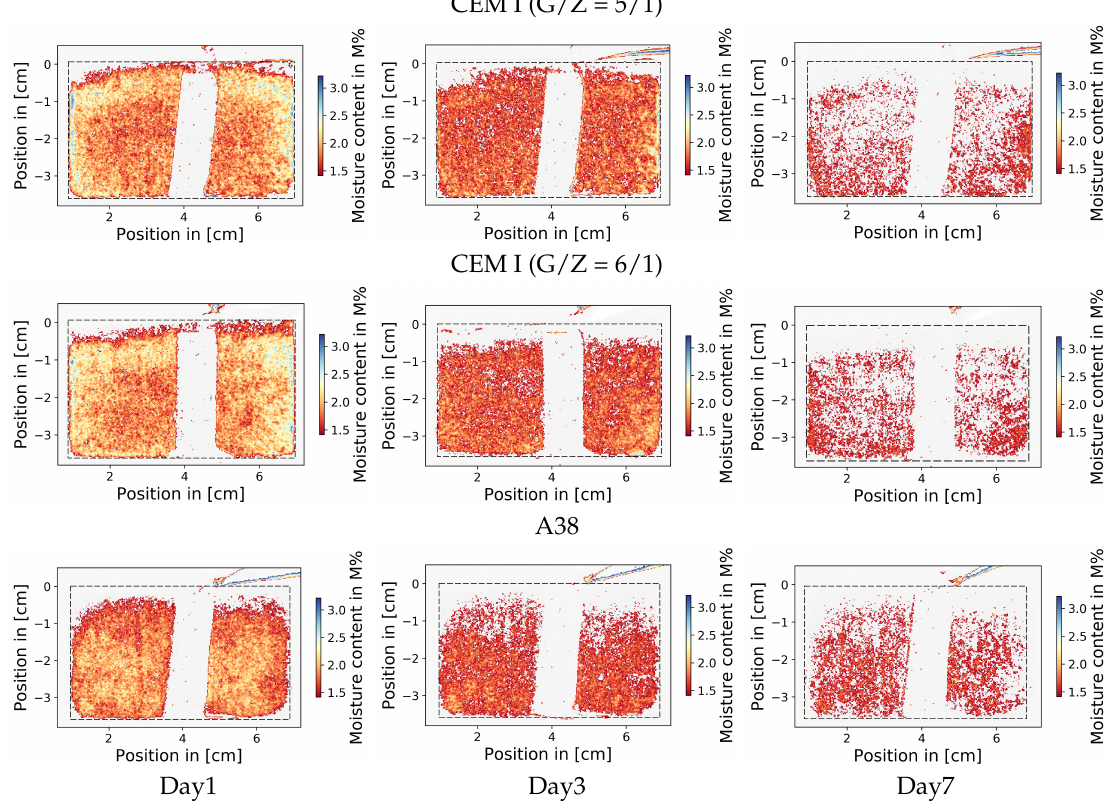
Figure 4. A 3 × 3 matrix of NR images, showing the drying process of 3 different samples over 3 different time-points. As an example, the leftmost column “Day 1” indicates that samples were measured after roughly 24 h. The dashed lines represent the edges of the sample. Blue and yellow colours indicate high water content, and red colours specify low moisture content. To minimise background noises, a water content under 1 M % is coloured white. As a result, the sensor and the thin layer of disproportionate dryness also appear in white, which can be seen at the top of the sample. Once more, it is illustrated that the upper part of the samples dried faster than the